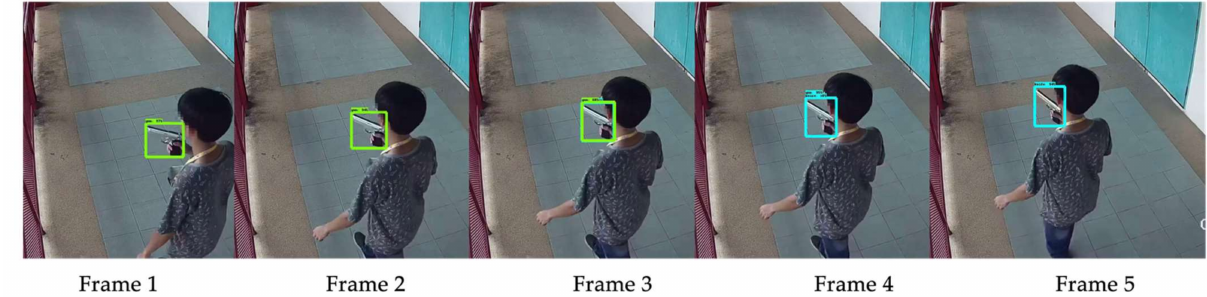
Figure A1. Weapon detection results on sequence images using the ACF Dataset on the SSD Mo- bileNet V2 model.